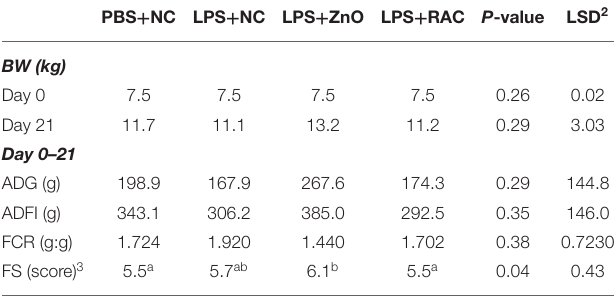
TABLE 1 | Experimental treatments and diets a . Treatments